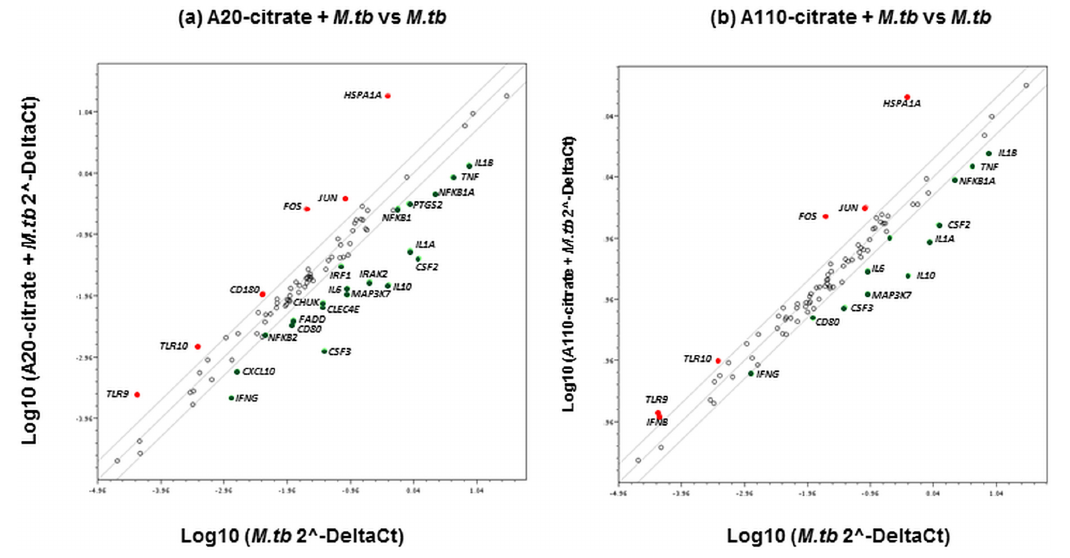
Fig 10. Comparison of Ag20 and Ag110 exposure effects on M . tb -induced gene expression. Scatter plots comparing the normalized expression of genes from M . tb infected MDM against that from MDM exposed to Ag20-citrate + M . tb ( a ) and Ag110-citrate + M . tb ( b ) are shown. The central lines represent unchanged gene expression. Upregulated and downregulated genes are indicated in red and green colors, respectively.